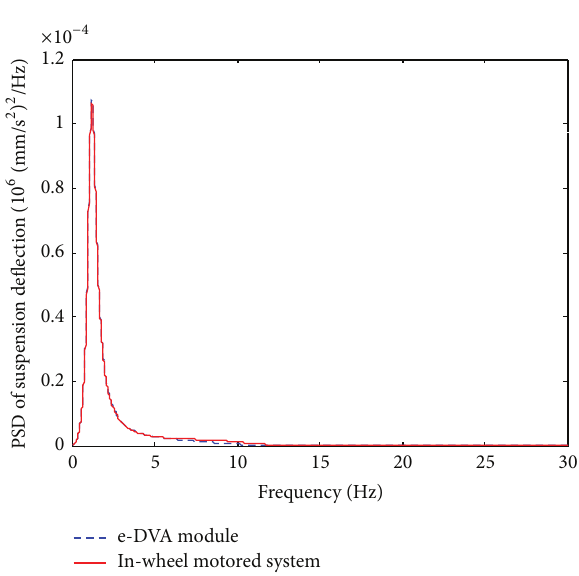
Figure 12: PSD comparison of suspension deflection.